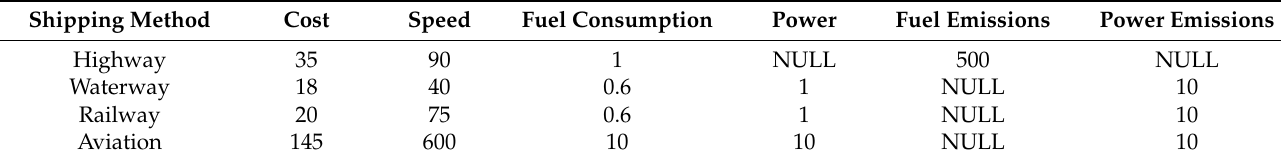
Table 1. Parameter assumptions for different modes of transport.